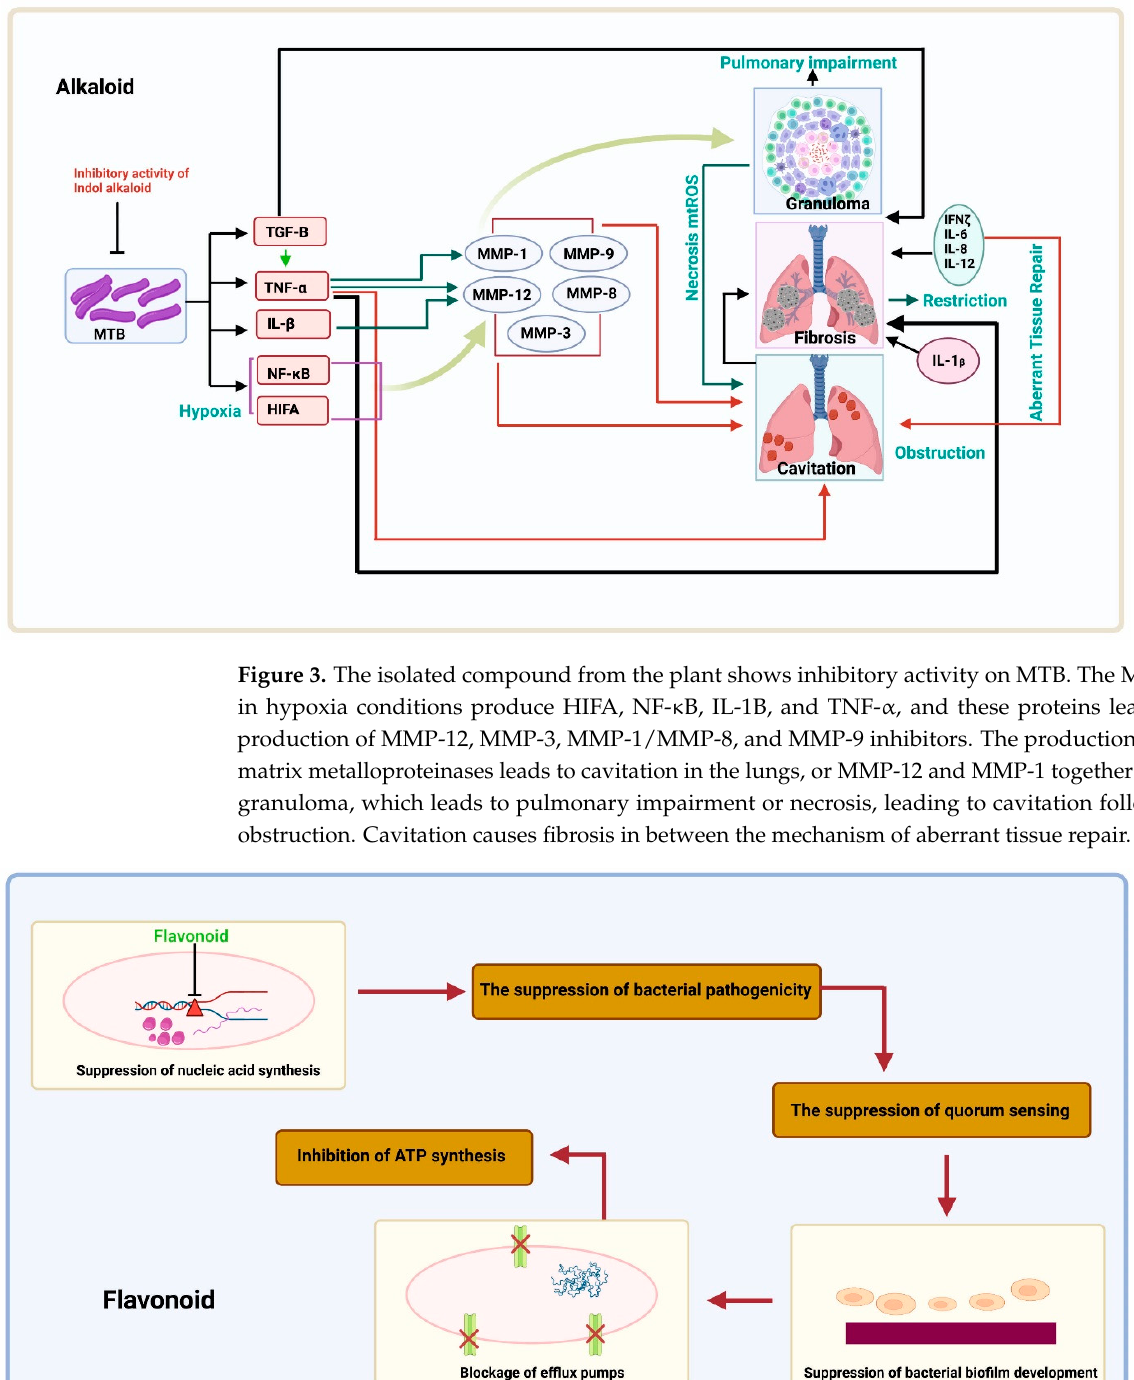
Figure 5. Mechanism of action of terpenoids. Terpenoids disrupt the cell membrane. The efflux pump is modulated, which might reverse antimicrobial resistance. The oxygen uptake process is blocked, resulting in the inhibition of oxygen. The oxidative phosphorylation process is altered,